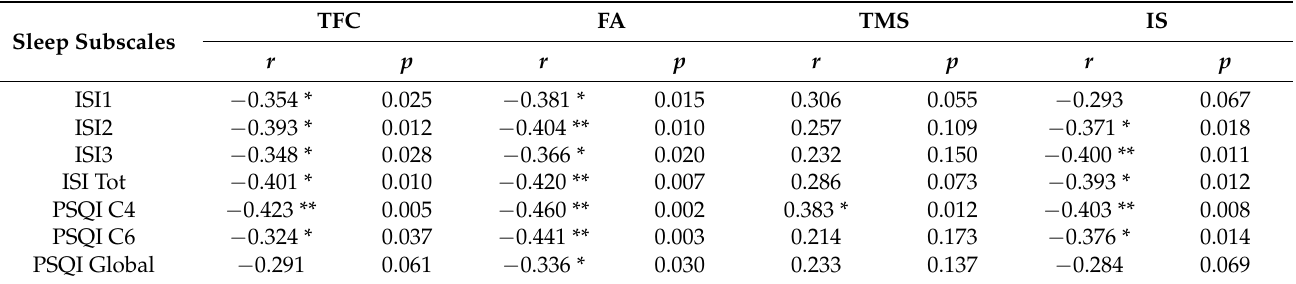
Table 2. Pearson’s correlations (and related level of significance) between motor/functional variables and sleep